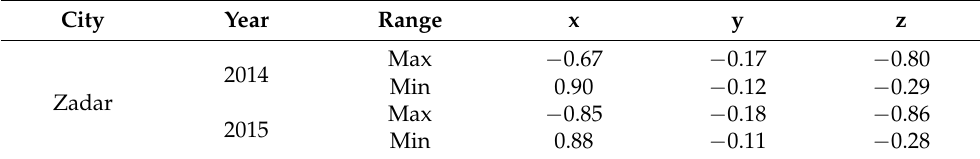
Table 5. Values of RTE corrections based on the proposed model for Zadar GNSS location (in m). City Year Range x y z Max − 0.67 − 0.17 − 0.80 2014 Min 0.90 Zadar